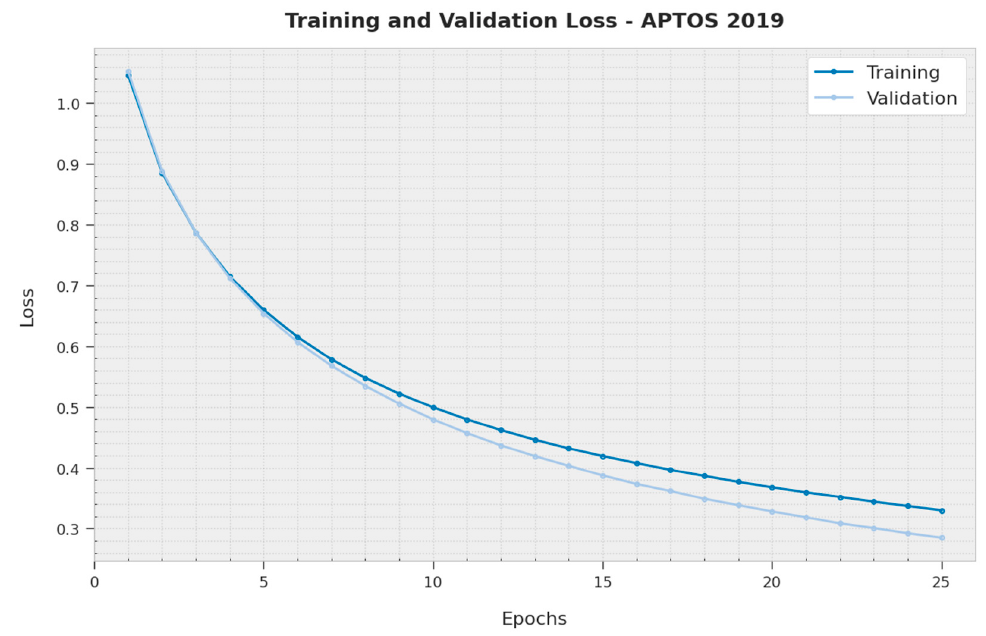
Figure 6. TL and VL analysis of the XAITO-DRGC approach under the APTOS 2019 dataset.